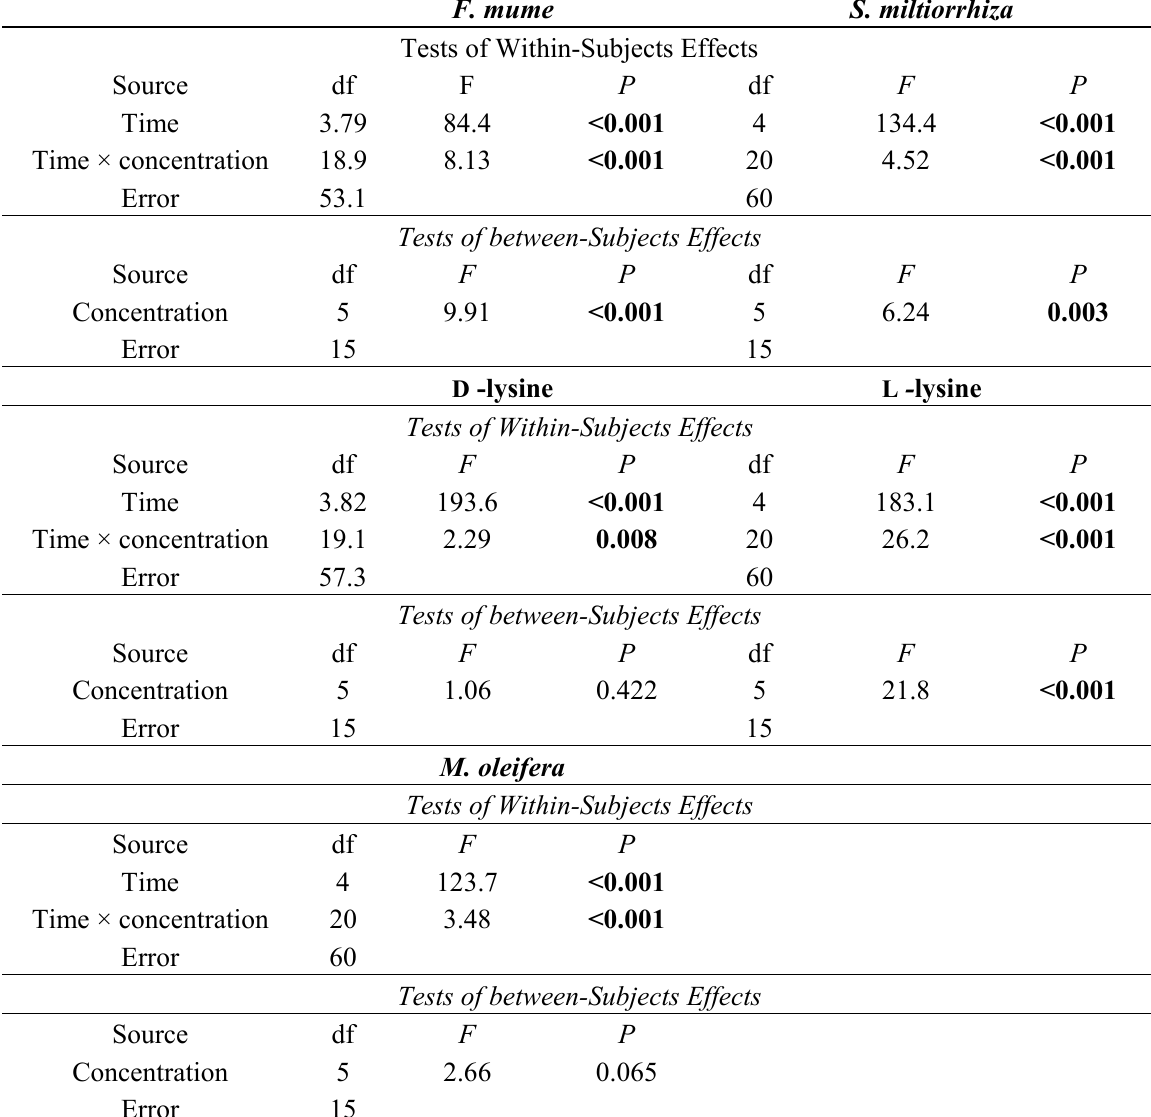
Table 5. Summary of repeated measures ANOVAs of Photosystem II efficiencies in Microcystis aeruginosa NIVA-CYA 43 populations exposed to different concentrations of extracts from Fructus mume, Salvia miltiorrhiza, Moringa oleifera and D -and L -lysine. Significant differences ( p < 0.05) are indicated in bold. If needed (Mauchly’s test), degrees of freedom (df) were corrected using Greenhouse-Geisser estimates of sphericity if epsilon <0.75 or the Huynh-Feldt correction if epsilon >0.75. F. mume S.